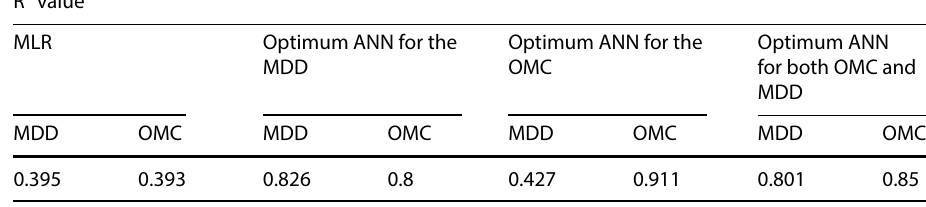
Table 12 the optimum ANN for predicting every compaction parameter individually and in combination